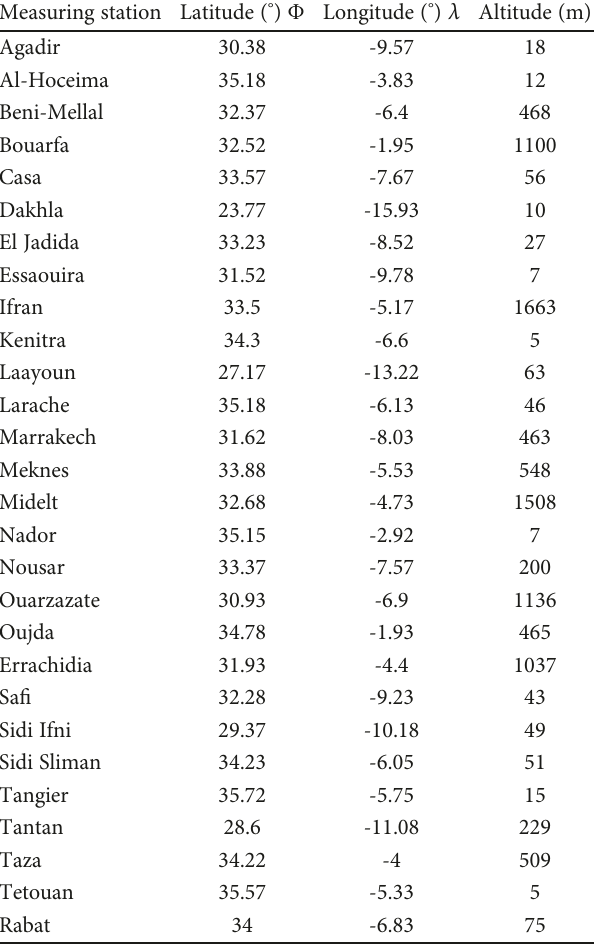
Table 3: The geographical data of the measuring stations ’ locations [40]. Measuring station Latitude ( ° ) Φ Longitude ( ° ) λ Altitude